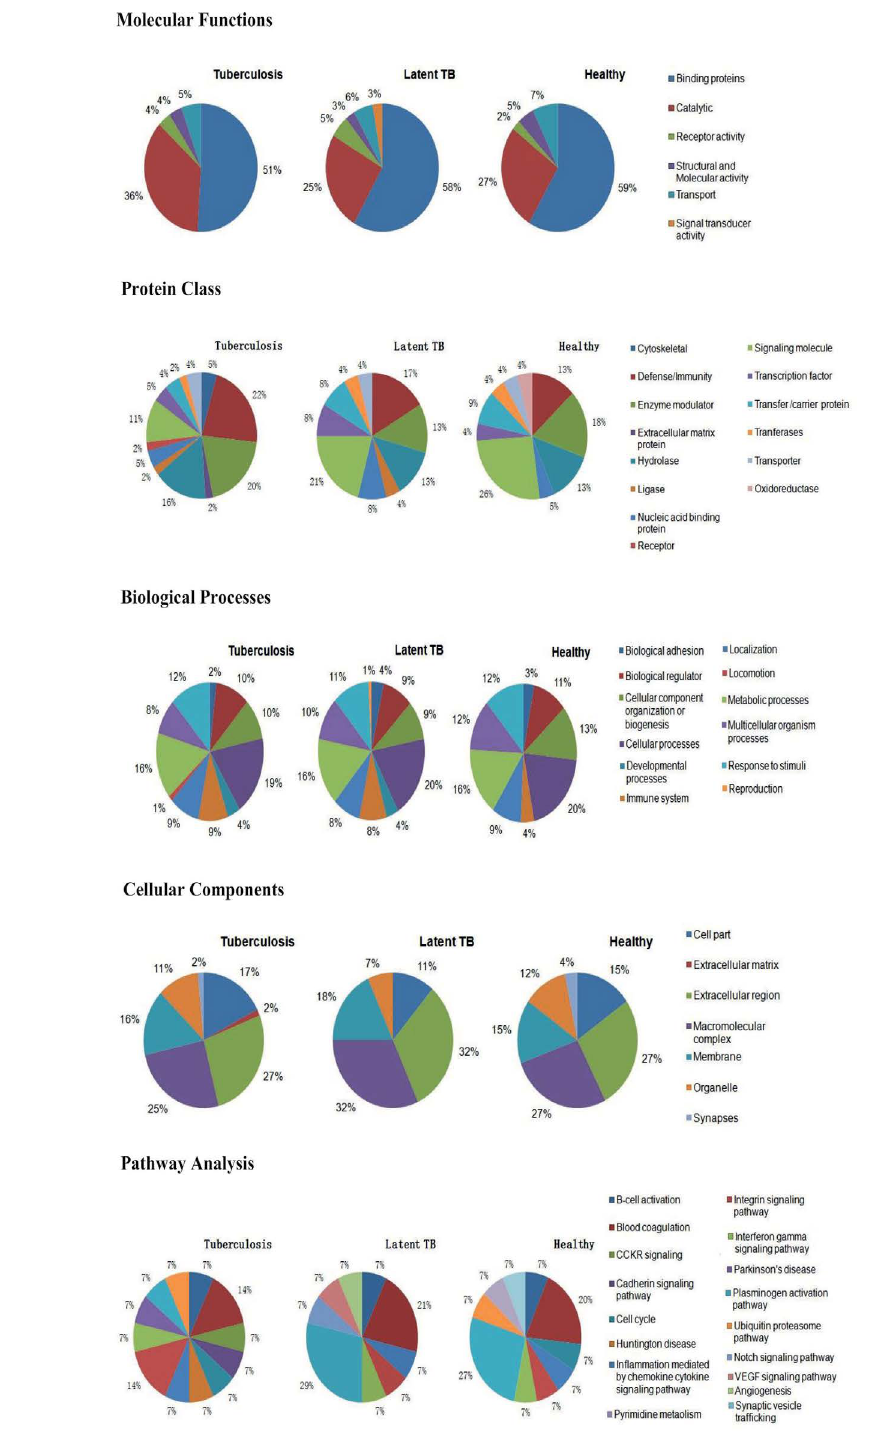
Fig. 3. Classification of proteins according to molecular function, protein class, biological processes, cellular component and pathway